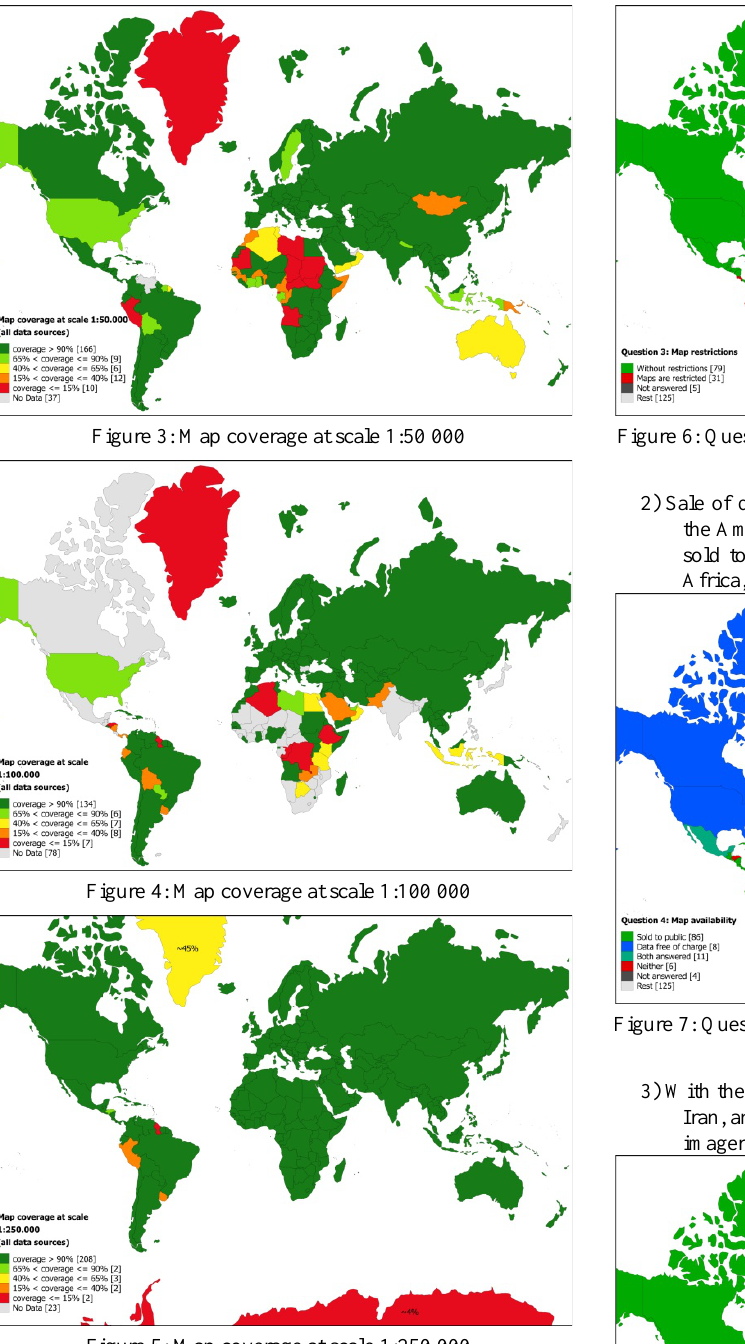
Figure 5: Map coverage at scale 1:250 000